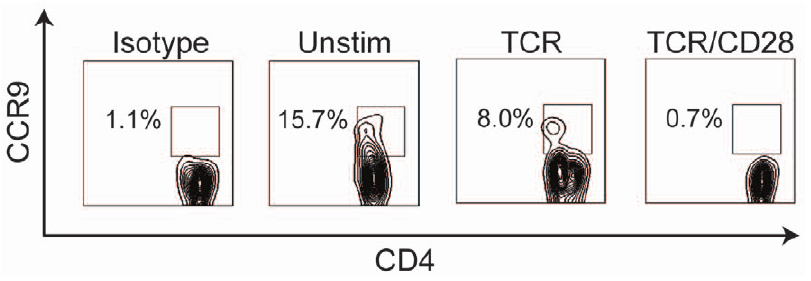
Figure 4. CD28 signaling downregulates CCR9 surface expression on CD4 T cells. Sorted naı¨ve CD4 + CD25- T cells from wild type C57BL/6 mice were stimulated with bead-bound anti-CD3 alone or anti-CD3 plus anti-CD28 for 72 h. CCR9 surface expression was examined by flow cytometry. These results are representative of at least 3 independent experiments.